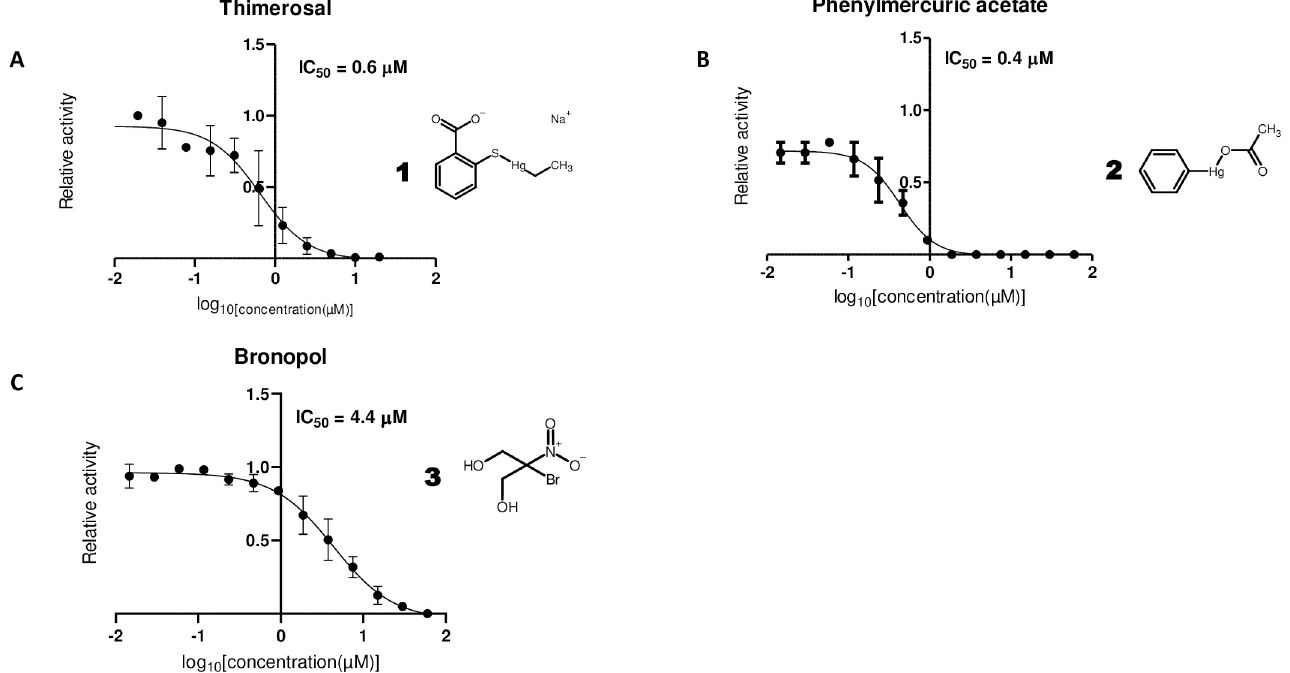
Fig 2. Effective compounds with known action against cysteines. Dose-response curves for (A) thimerosal, (B) phenylmercuric acetate, (C) bronopol. Half- maximum inhibitory concentration (IC 50 ) values were determined by nonlinear regression using 10 μ M substrate and 0.5 μ M enzyme with varying concentrations of